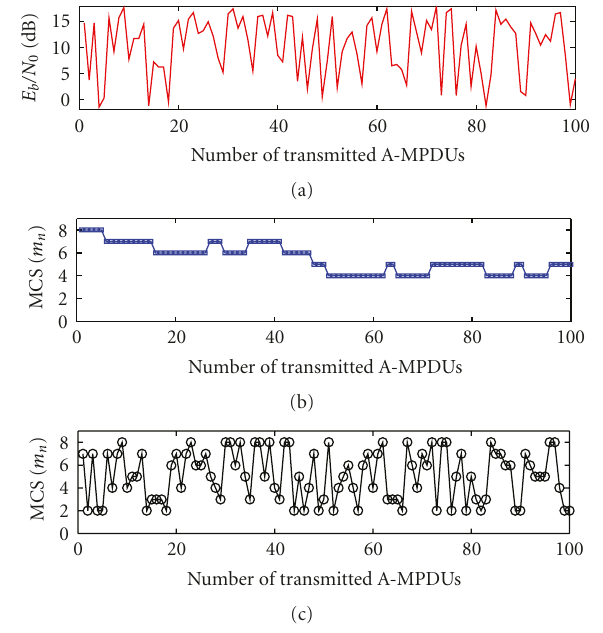
Figure 10: (a) the channel conditions within di ff erent transmission attempts generated by the two-state discrete Markov chain model with P b , g = 0 . 7. (b) the MCS scheme adopted by the ARF algorithm in every transmission attempt. (c) the MCS scheme exploited by the proposed FALA algorithm in every transmission attempt.